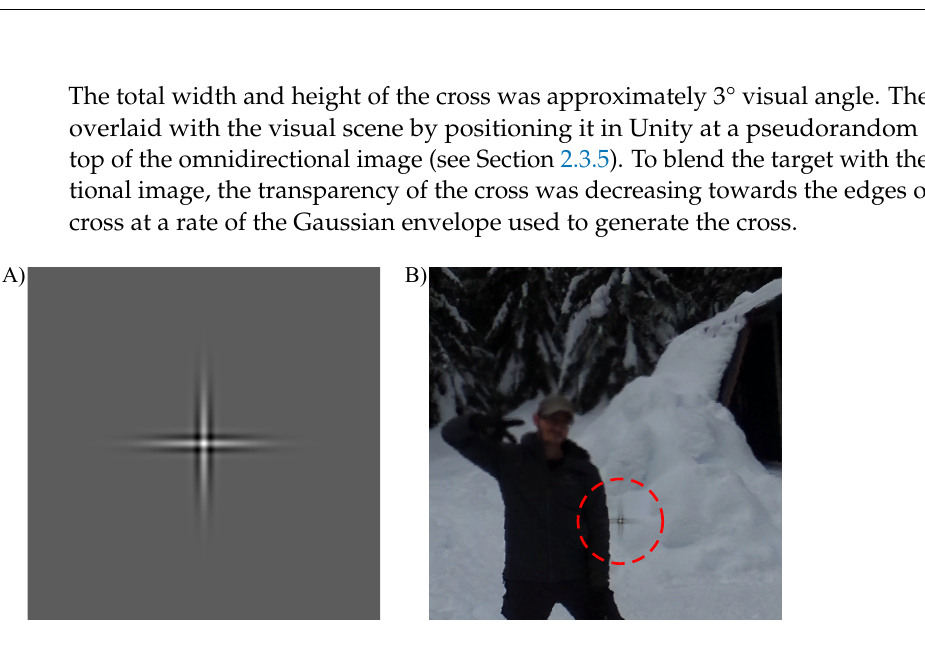
Figure 4. ( A ) The Gabor cross was used as a search target in the visual search task. It is a sum of vertical and horizontal Gabor stimuli, where each of the Gabors is a product of 8cyc/° cosine function with Gaussian envelope with standard deviations of 0.06° and 0.32°. ( B ) An example of the search target is overlaid with a visual scene at a pseudorandom location. For simplicity, the cross is highlighted by a surrounding red dashed line. In the experiment, the red line was not